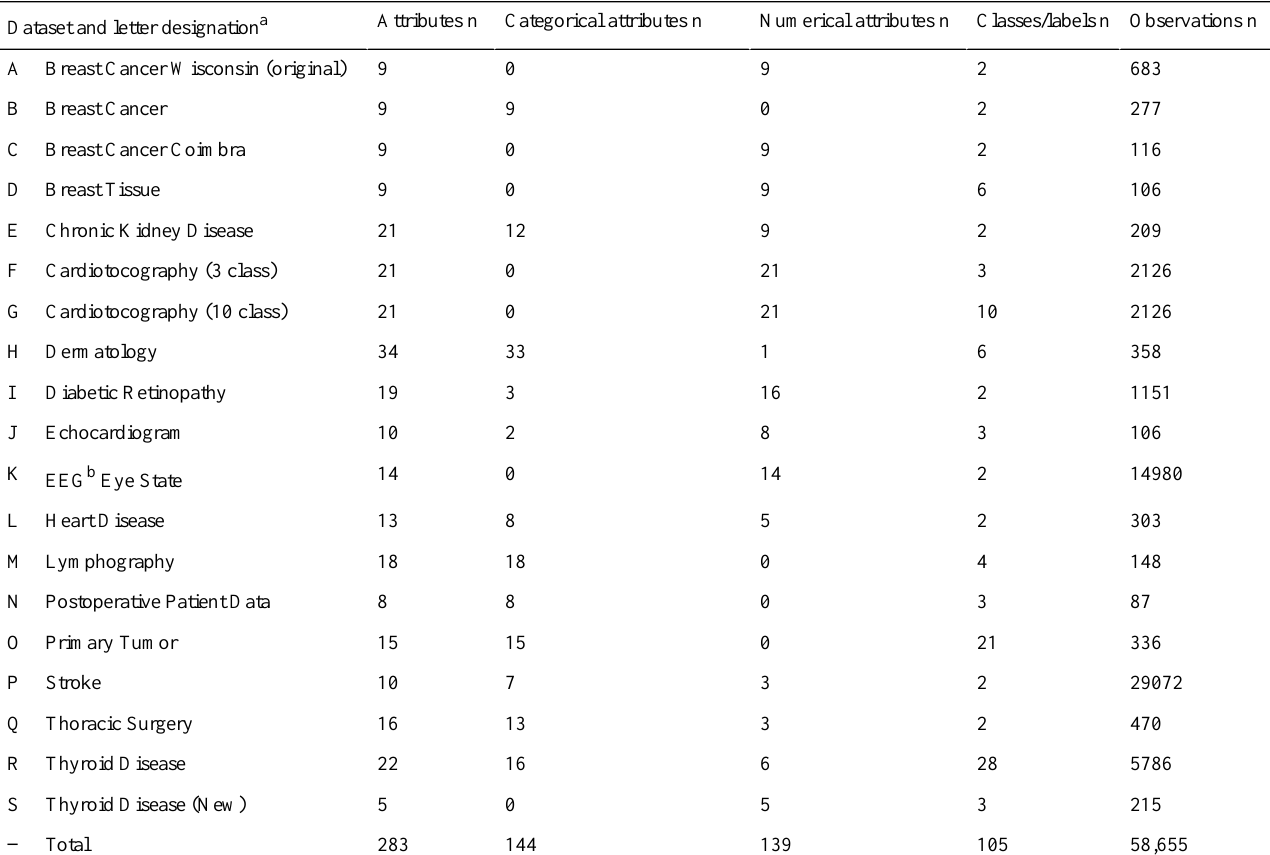
Table 1. Summary of experimental